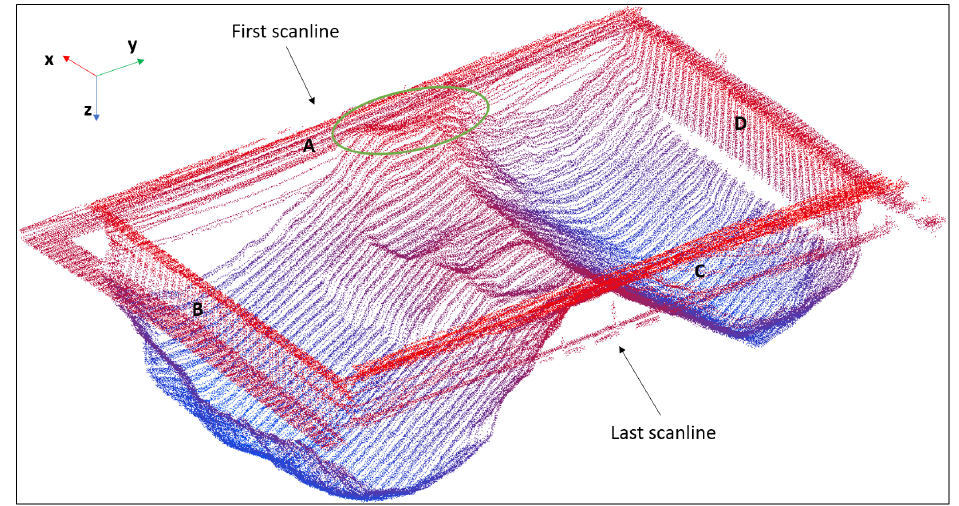
Figure 8. Example of voxelized point cloud after swipe scanning in full hatch scenario. The bulk cargo was stacked above the hatch edge in the green ellipse